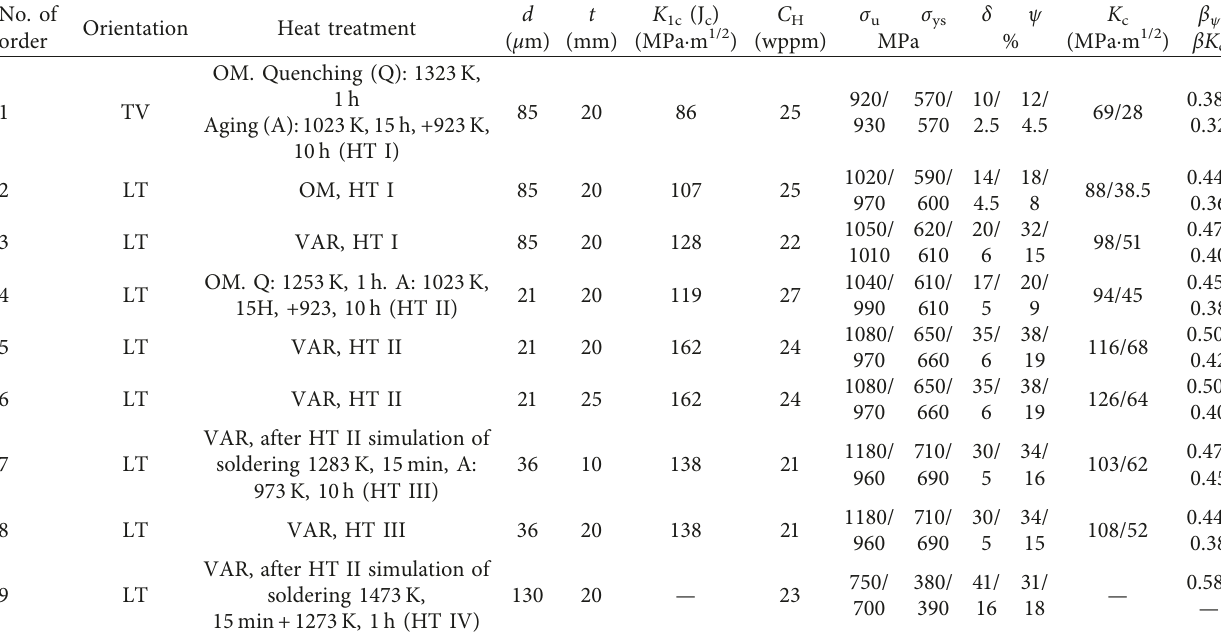
Table 2: Characteristics of the 05Cr19Ni55 alloy modifications at 293K and displacement rate 0.1mm/min.